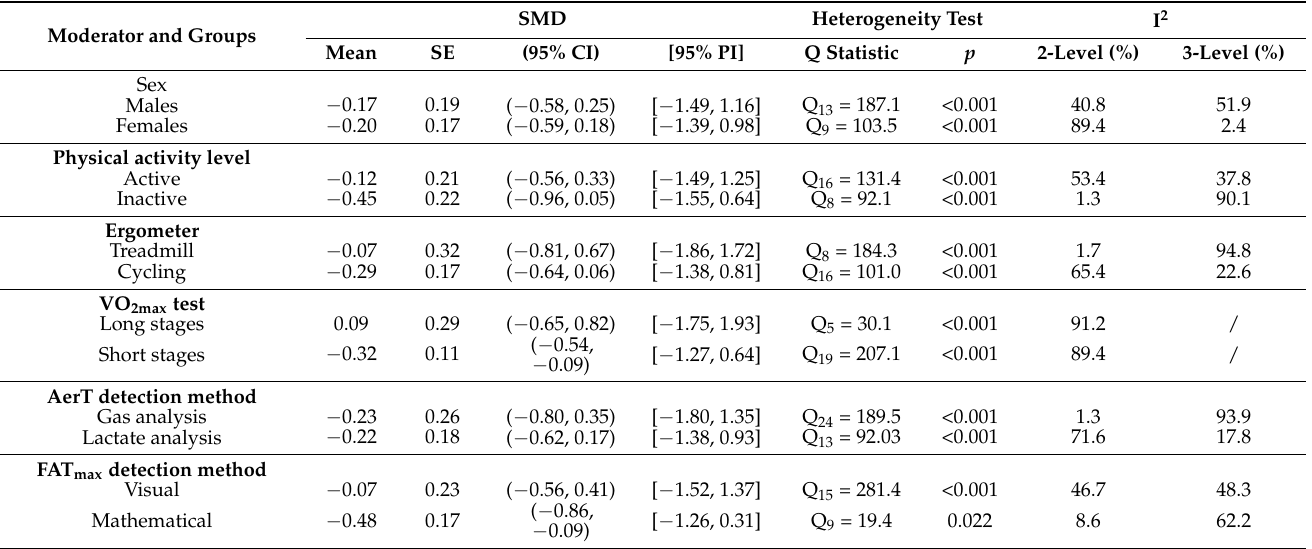
Table 3. Subgroups meta-analysis for SMD. NOTE : A negative mean indicates FAT max preceded